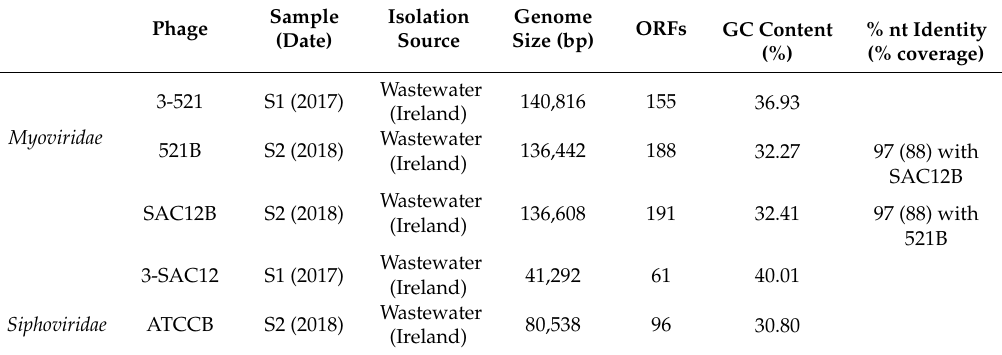
Table 3. General characteristics of Lb. brevis